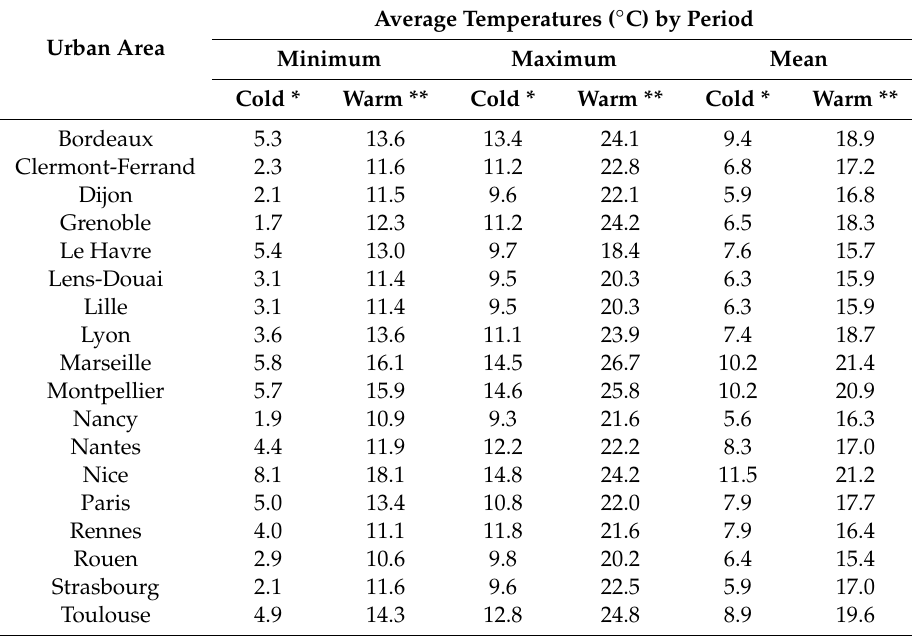
Rouen Strasbourg